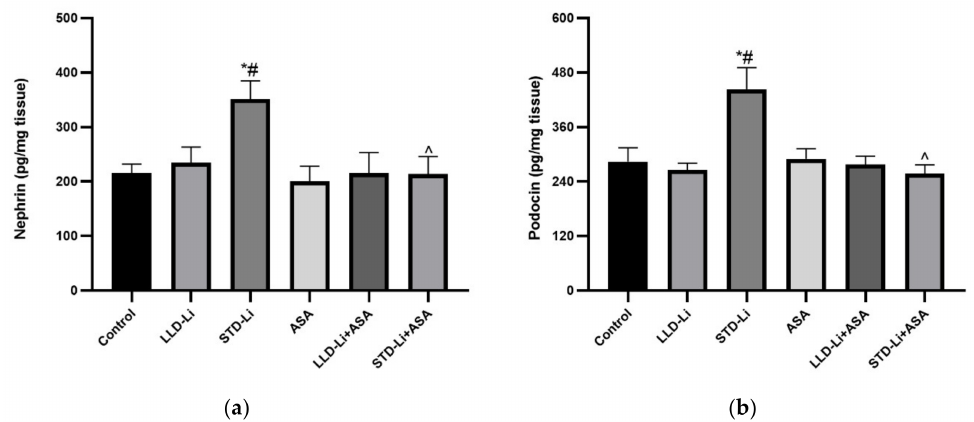
Figure 5. Nephrin and podocin levels in aspirin + Li-treated rats. Rats were fed regular food (control) or lithium-containing food [LLD-Li or STD-Li] for 42 days. Low-dose aspirin (1 mg/kg, ip) was given alone or together with lithium. On day 42 the rats were sacrificed, kidneys excised and homogenized, and nephrin ( a ) and podocin ( b ) levels determined by ELISA as described in Materials and Methods. Results are the means ± SEM of a single representative experiment out of two demonstrating a similar pattern with 8 rats per group in the depicted experiment. * p < 0.05 vs. Control, # p < 0.05 vs. LLD-Li, ˆ p < 0.05 vs. STD-Li. ( a ) Nephrin—two-way ANOVA: ASA effect: F 1,30 = 5.4, p =